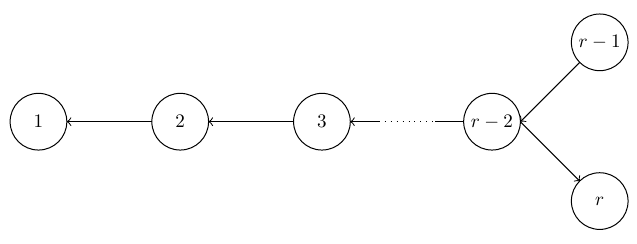
Figure 5 . Dynkin diagram of a D r Lie